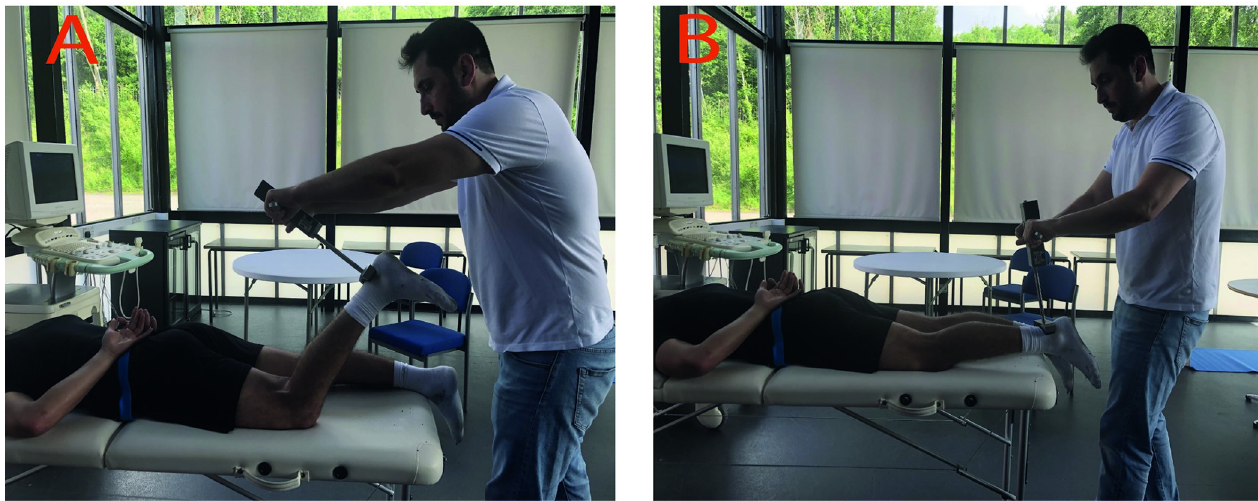
Fig 3. Hamstrings’ eccentric maximum strength measurements by handheld dynamometry. The hip joints were neutral (0 degrees of hip extension) during the measurements. A: The starting point of the measurement was when the knee was approximately 60˚ flexed and when the handheld dynamometer was on the two centimetres proximal to the malleolus of the ankle. B: The ending position of the hamstrings’ maximum eccentric strength measurement. The individual pictured in Fig 3 has provided written informed consent (as outlined in PLOS consent form) to publish their image alongside the manuscript.